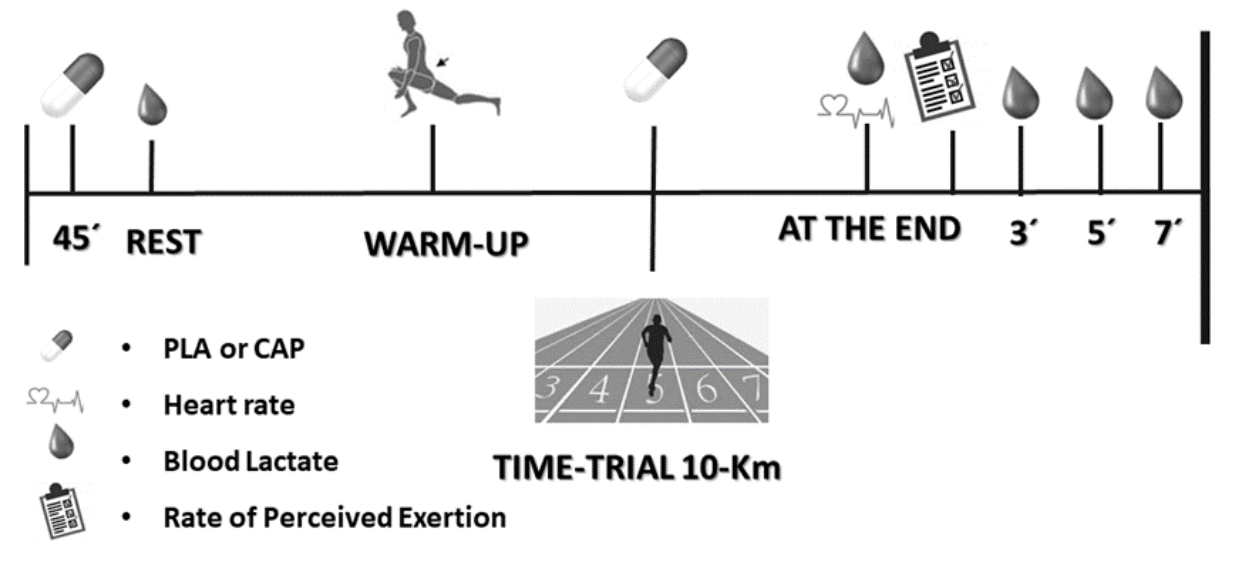
Figure 1. Experimental design. PLA = placebo. CAP = capsaicin.